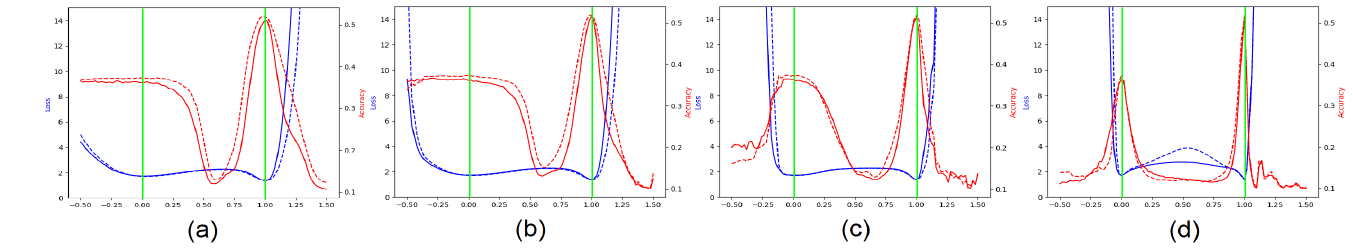
Figure 4. ( a ) Loss/accuracy profiles obtained by linearly interpolating between two optimized MLP A and B . Network A is for x = 0 and B for x = 1 (green vertical lines). Dotted lines are for training and solid lines for validation. Remaining plots are similar interpolations but between teleported versions of A and B with CoB range σ of ( b ) 0.6, ( c ) 0.9, and ( d )